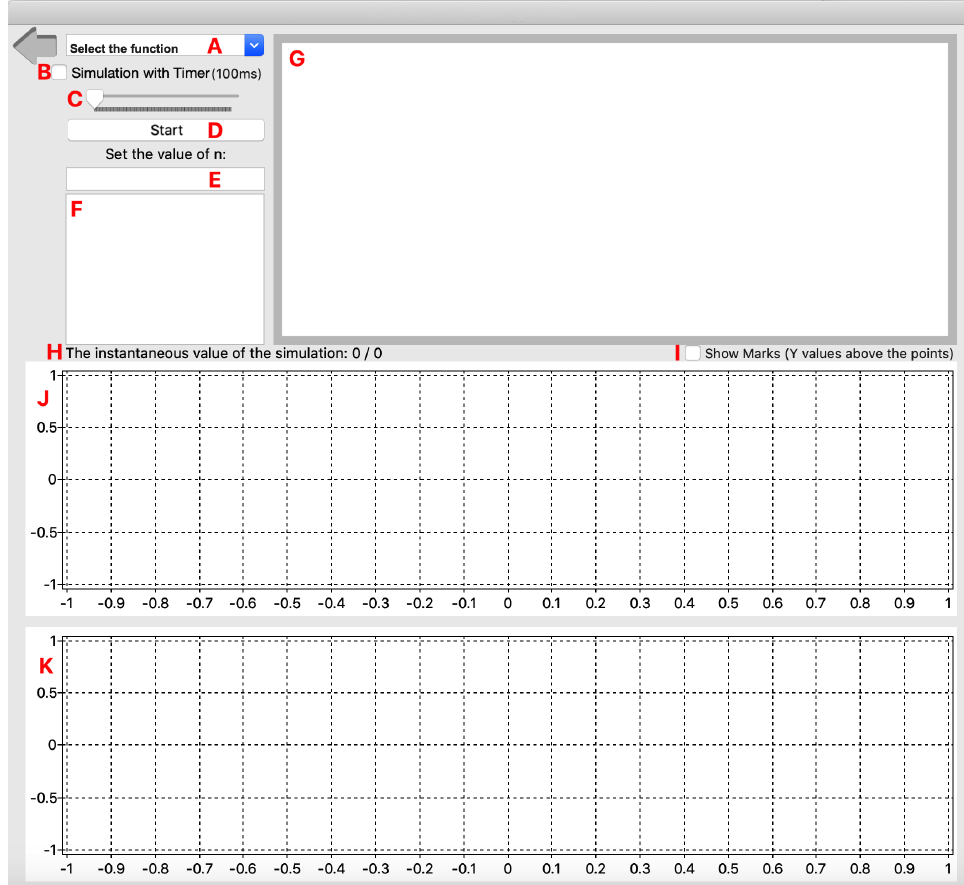
Figure 1. User interface of the